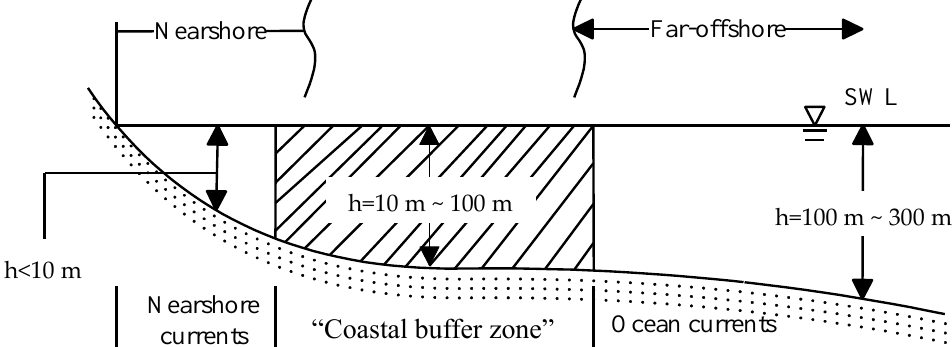
Figure 1. Definition of coastal buffer zone based on marine physics [25].